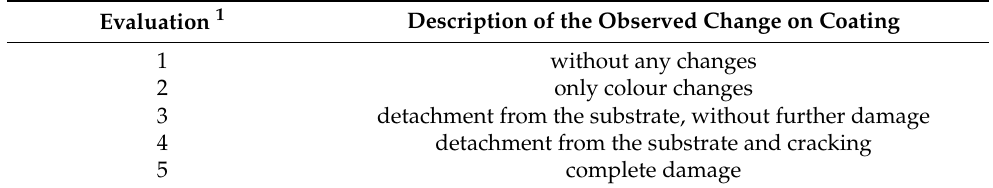
Table 4. Evaluation system for assessing chemical resistance from a visual point of view.